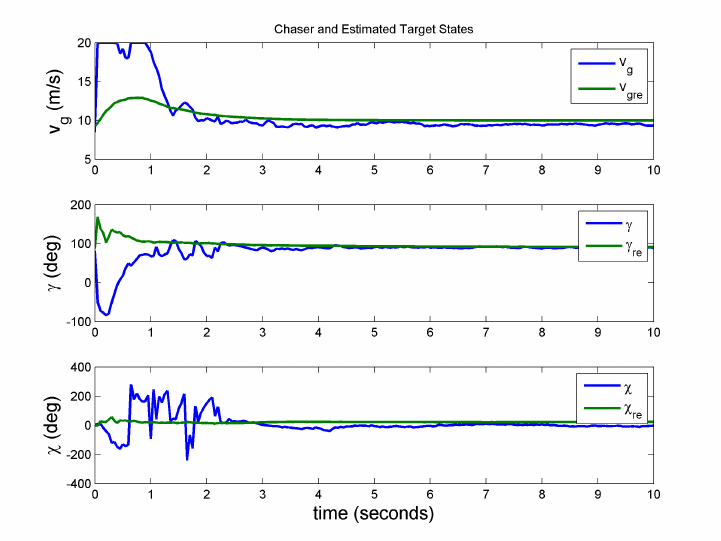
Figure 10. Speed, flight path angle and heading angle tracking (Case 1B).